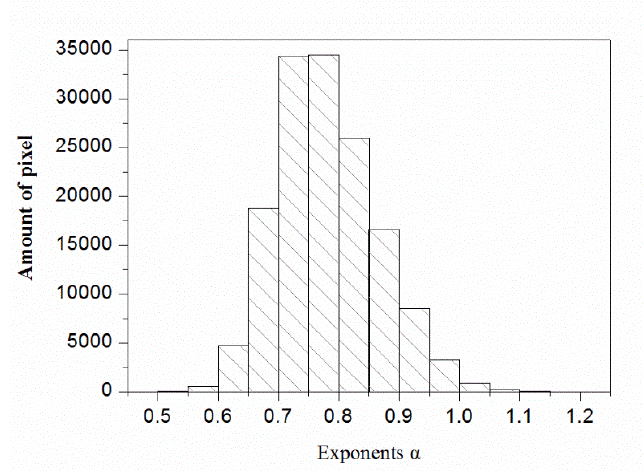
Figure 6. The range of DFA exponent α values at various latitudinal zones. The bottom and top of the box are 1st and 3rd quartile, respectively; the band inside the box is median value (2nd quartile); the square inside the box is mean value; the lower and upper crosses are 1st and 99th percentile, respectively; the lower and upper dashes are 1.5 interquartile range of lower and upper quartiles, respectively; and the bottom and top circles are the minimum and maximum values, respectively.